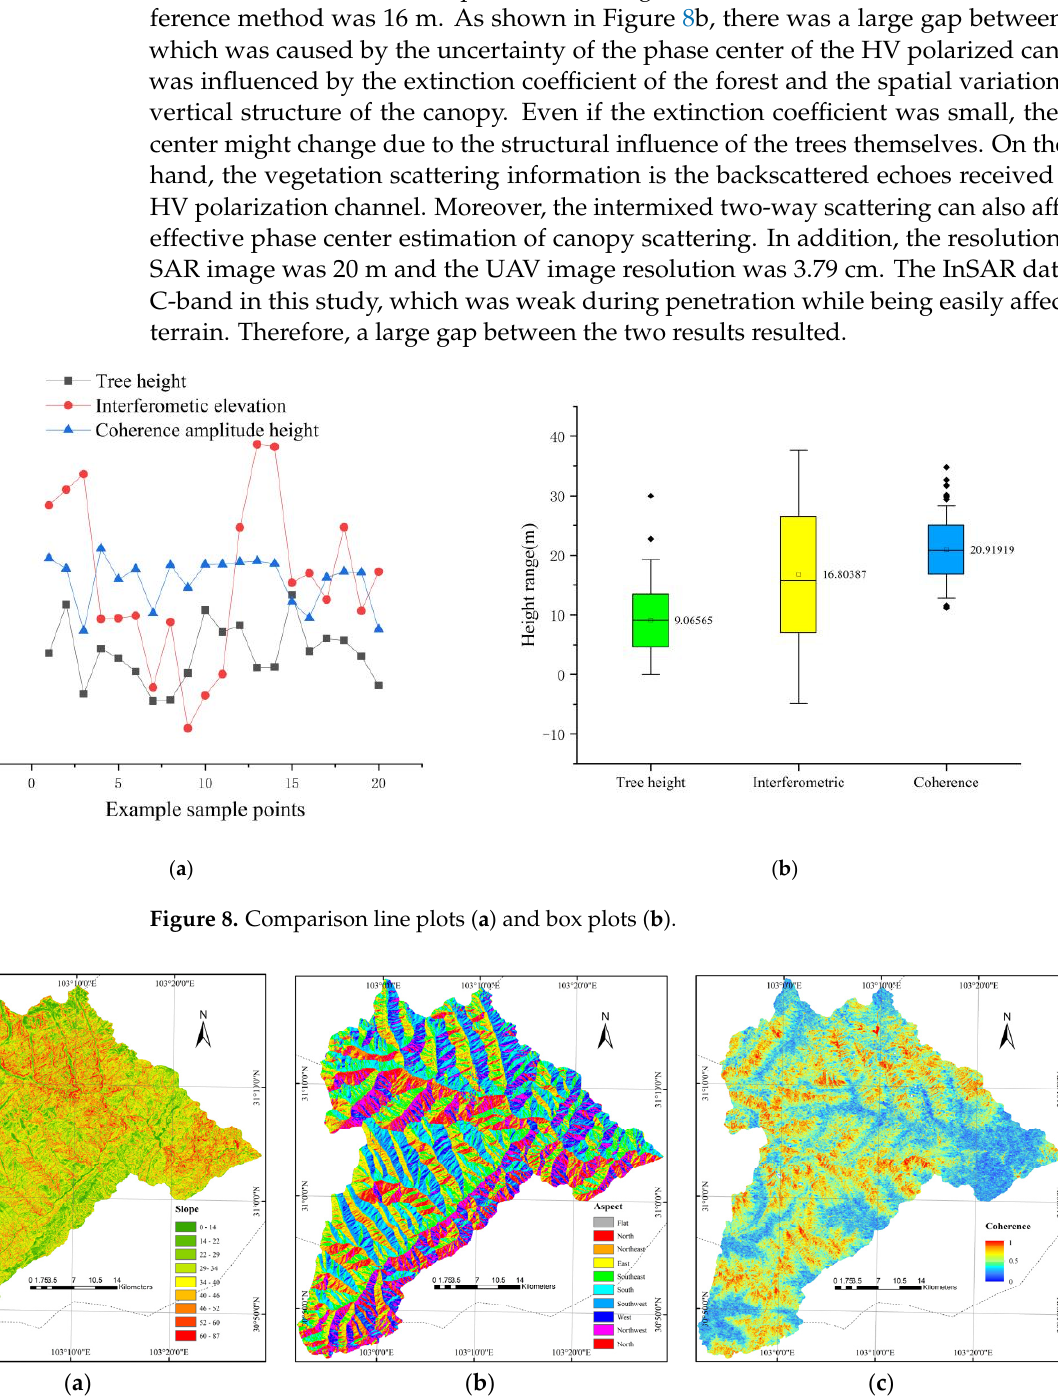
with random forest for modeling, respectively.